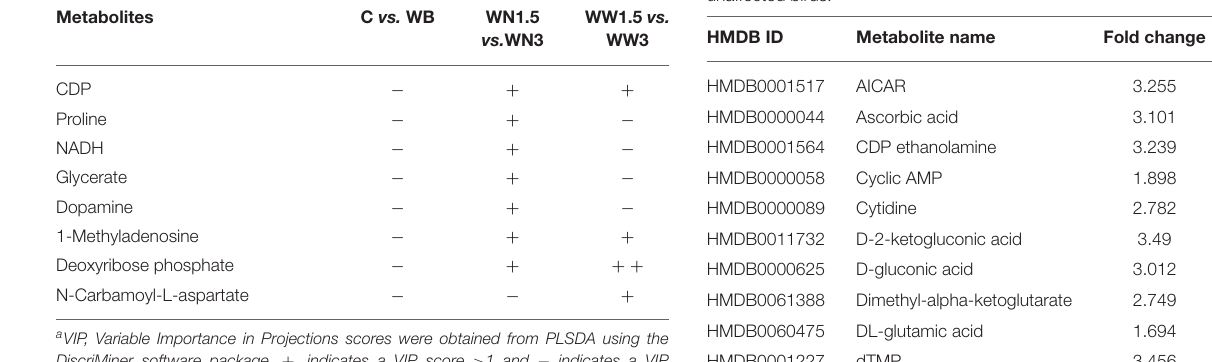
TABLE 2 | Differentially abundant metabolites in woody breast-affected and unaffected